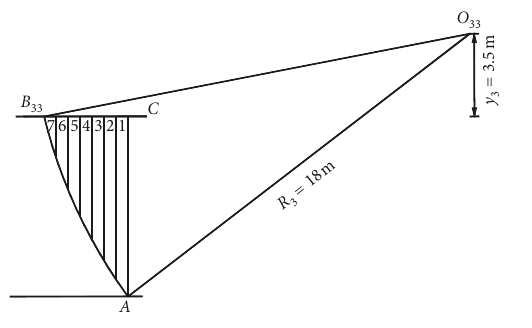
Figure 5: The coal band division. Table 2: The geometric parameters of coal band and the calculation results of q m .